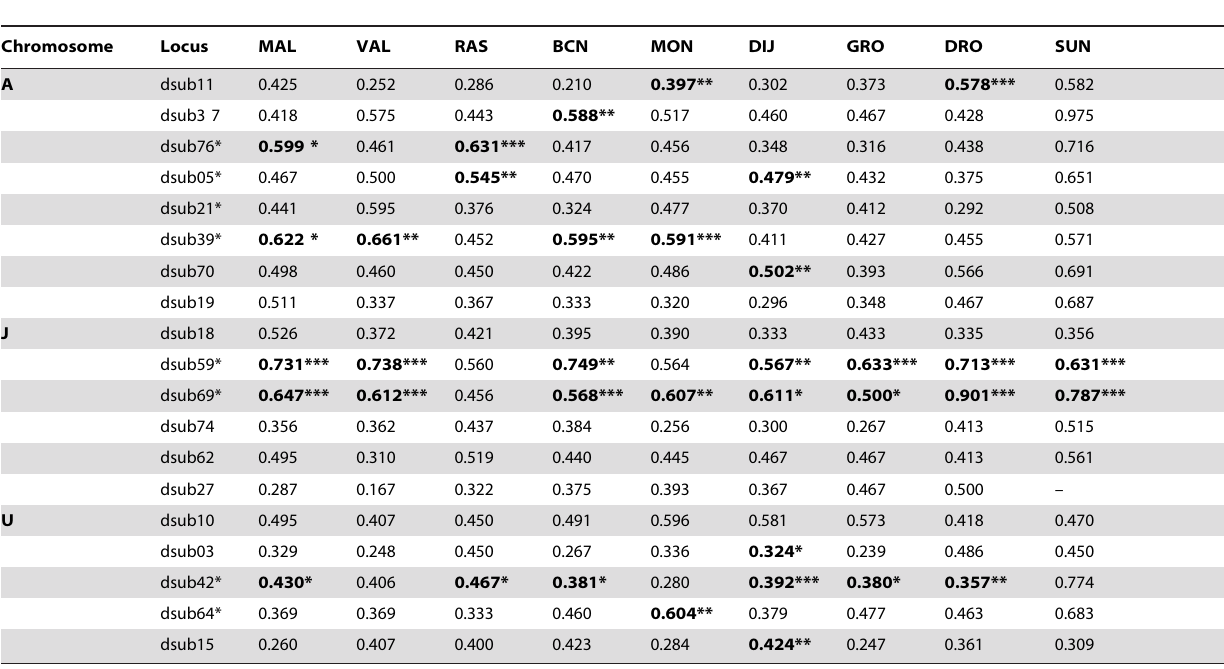
Table 2. D 9 m statistic between microsatellite loci and arrangements for each chromosome in the nine analyzed populations.